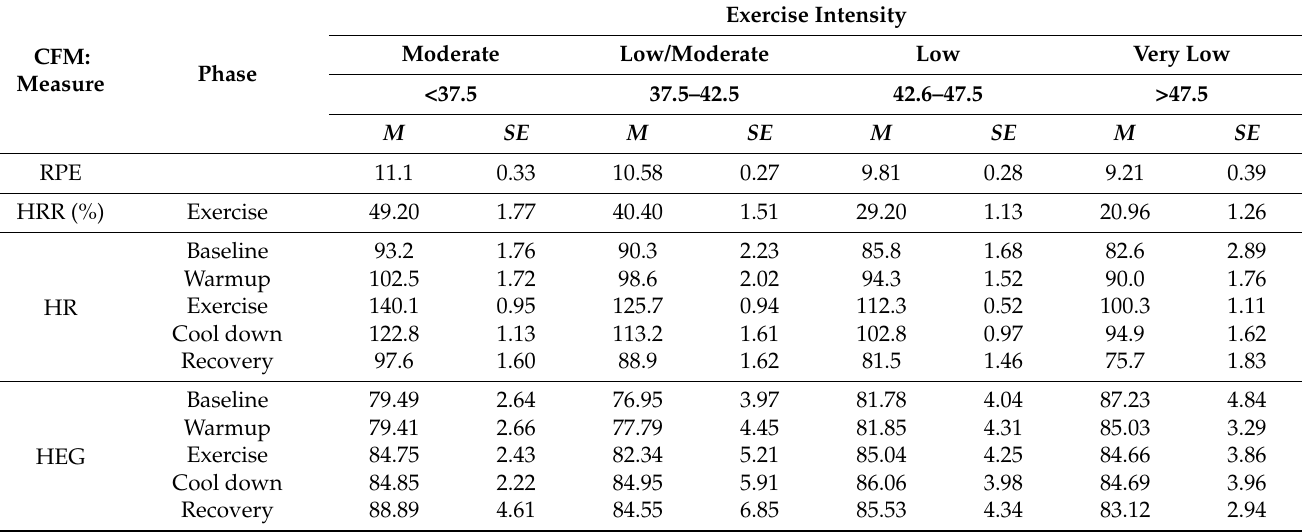
Table 2. Heart rate and prefrontal HEG changes between phases in the four groups ( N =